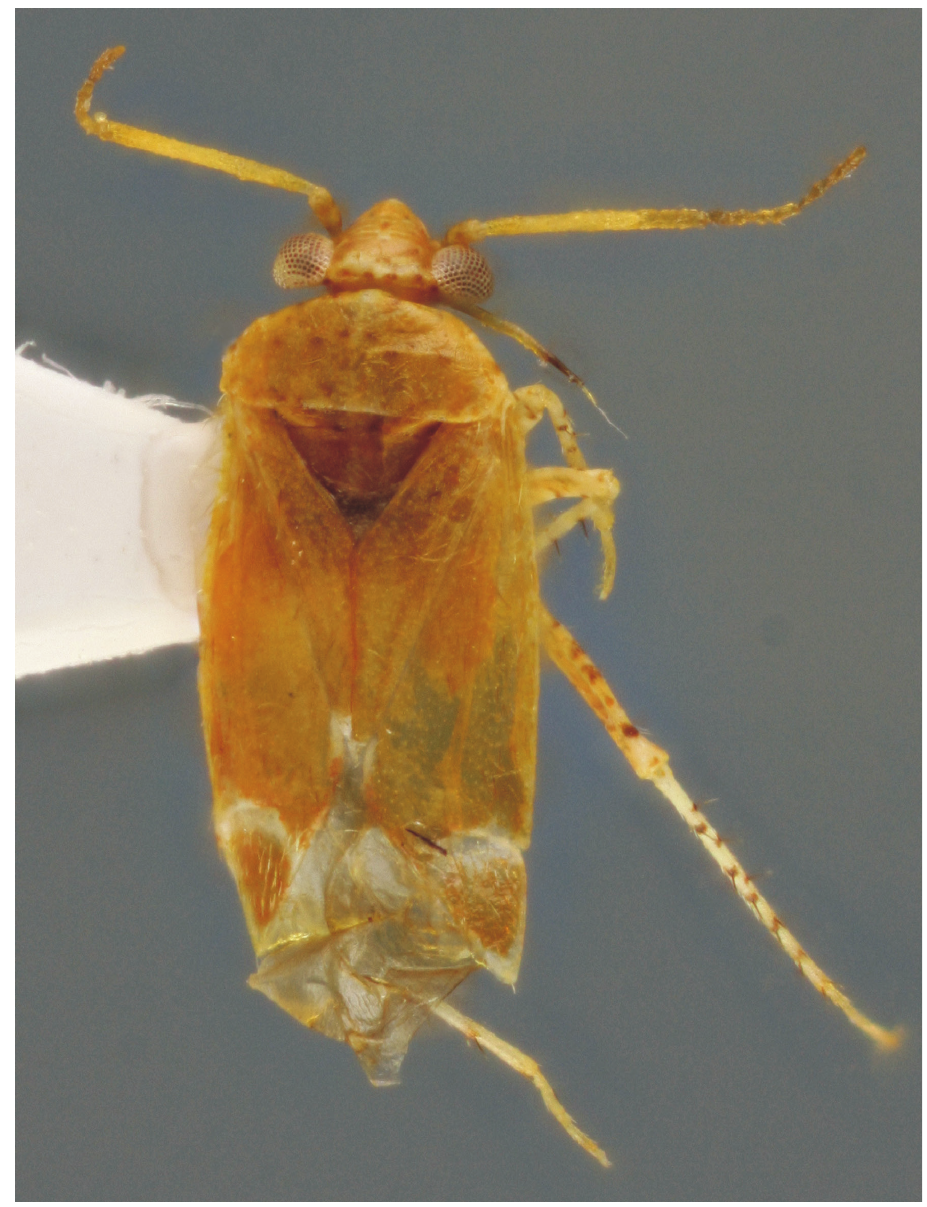
Figure 1. Habitus of Psallus thomashenryi sp. n., holotype, male (2.29 mm). Pubescence. Dorsum with reclining pale and semierect blackish setae; the latter few, mostly on head and lateral margins of pronotum. Female. Coloration similar to males but paler. Structure and pubescence as in males, but body more ovoid, 2.8 times longer than basal width of pronotum;